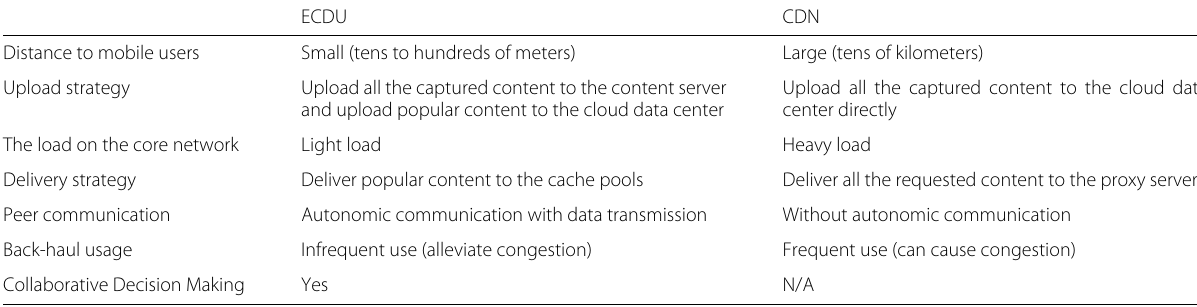
Table 2 Comparison of features: ECDU vs. CDN ECDU CDN Distance to mobile users Small (tens to hundreds of meters) Large (tens of kilometers) Upload